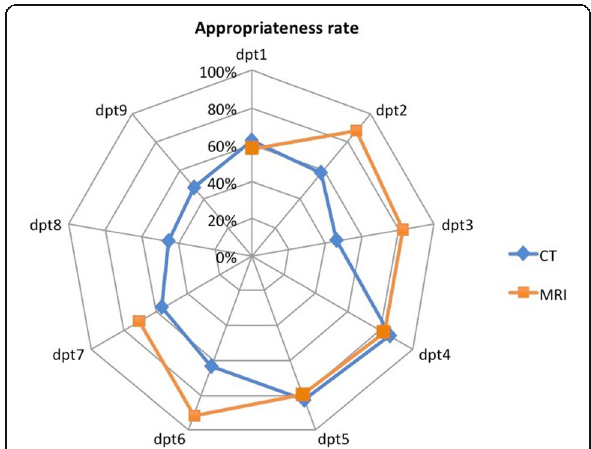
Fig. 3 Radar chart showing AR for each radiology department (dpt) for CT and MRI